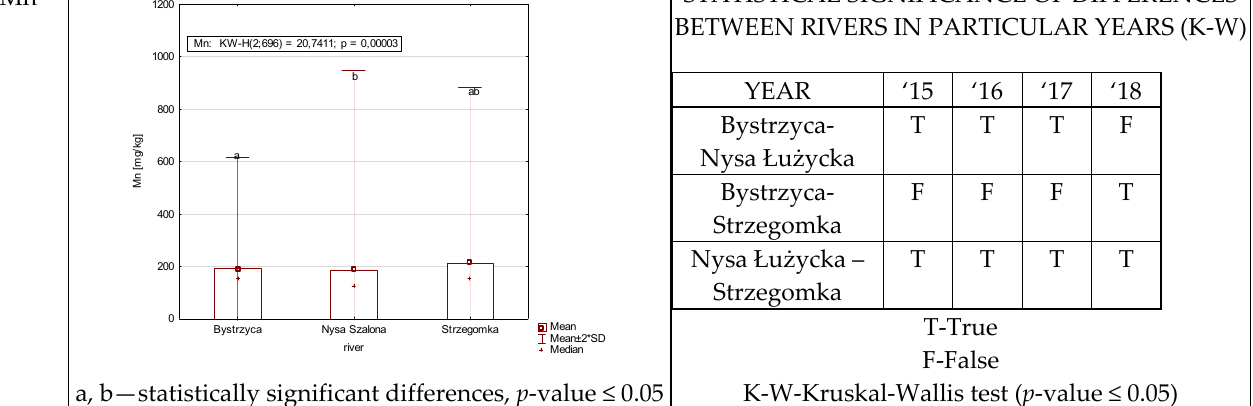
Figure 7. Mn concentration in plants from rivers across 29 sites depending on river (graph to the ( left )) and by year 2015–2018 in the table to the ( right ). Statistically significant differences are marked in the graph with letters a, b and in the table these differences are shown by year between rivers—T—differences were present, F—no statistical difference ( p -value ≤ 0.05).